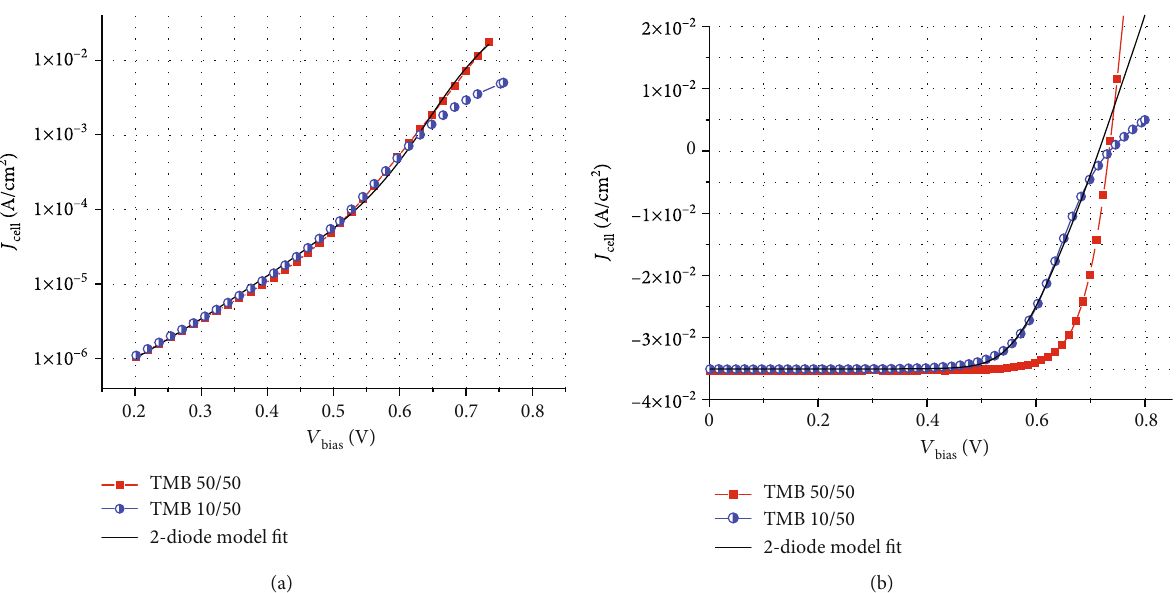
Figure 11: I-V characteristics for samples TMB 10/50 and TMB 50/50 under (a) dark conditions and (b) light conditions, both with the 2- diode model fi tting.